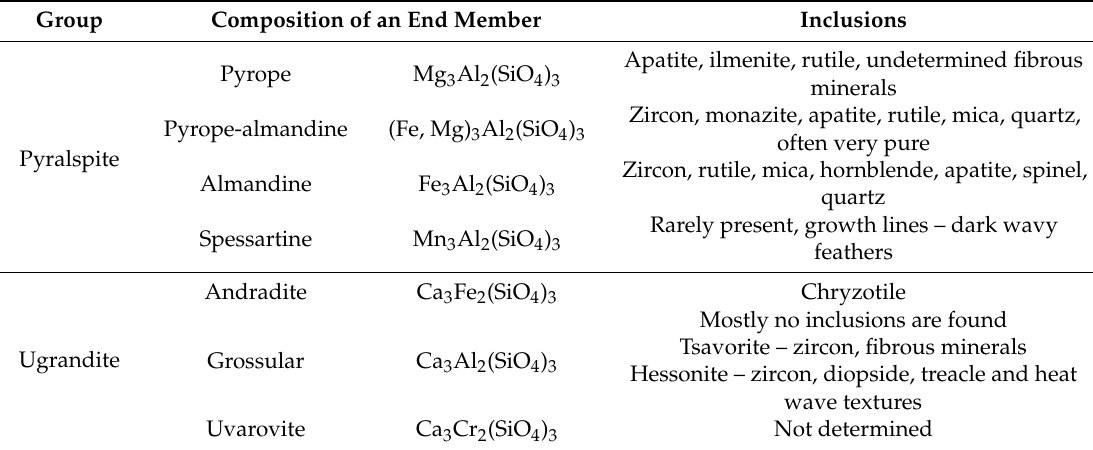
Table 1. Commonly recognized solid inclusions in garnets [30,31].